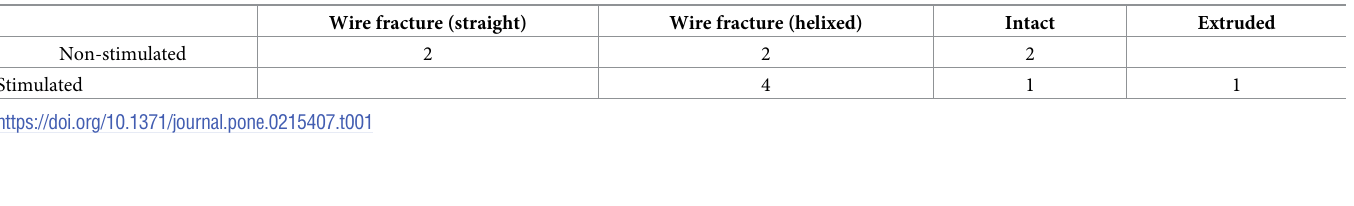
Table 1. In-vivo x-ray implant